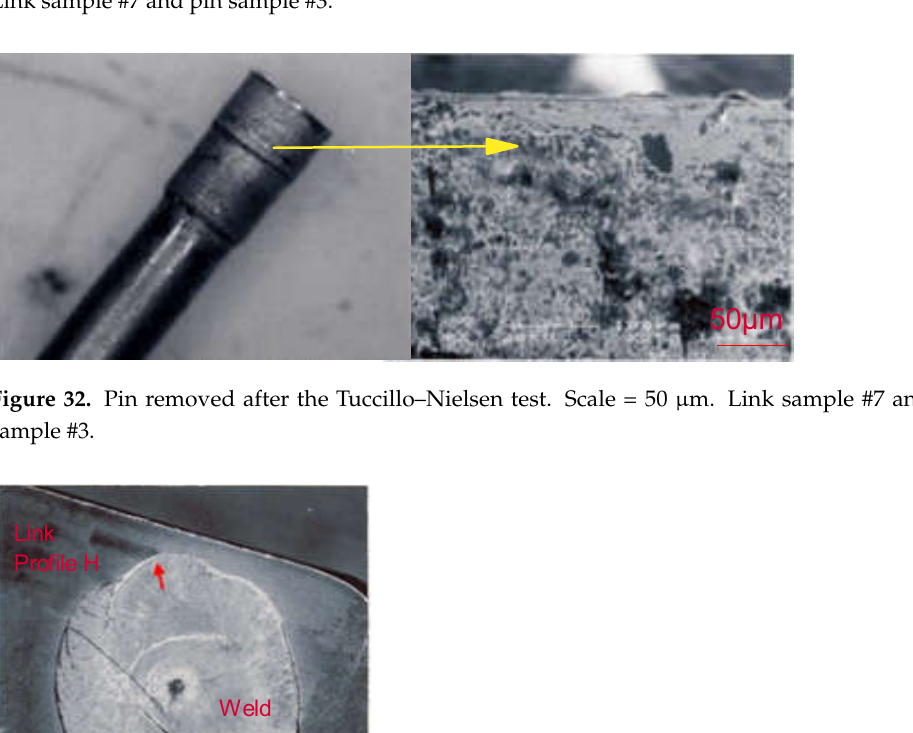
Figure 31. Crevice corrosion at the link/driven pin interface. Optical examination, magnification 20×. Link sample #7 and pin sample #3.